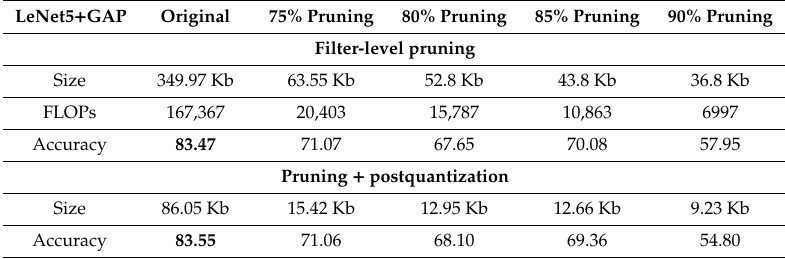
Table 11. Comparison in terms of size and Flops of filter-level pruning on LeNet5 + GAP with th plant seedlings dataset.